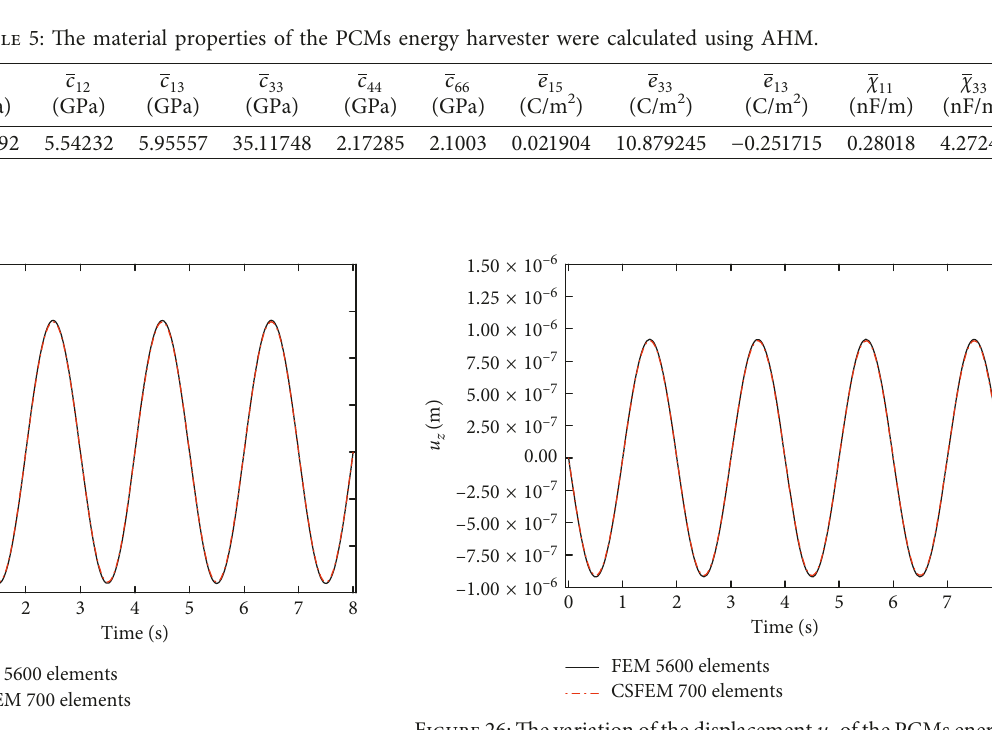
Figure 25: The variation of the displacement u energy harvester at point A with respect to time.